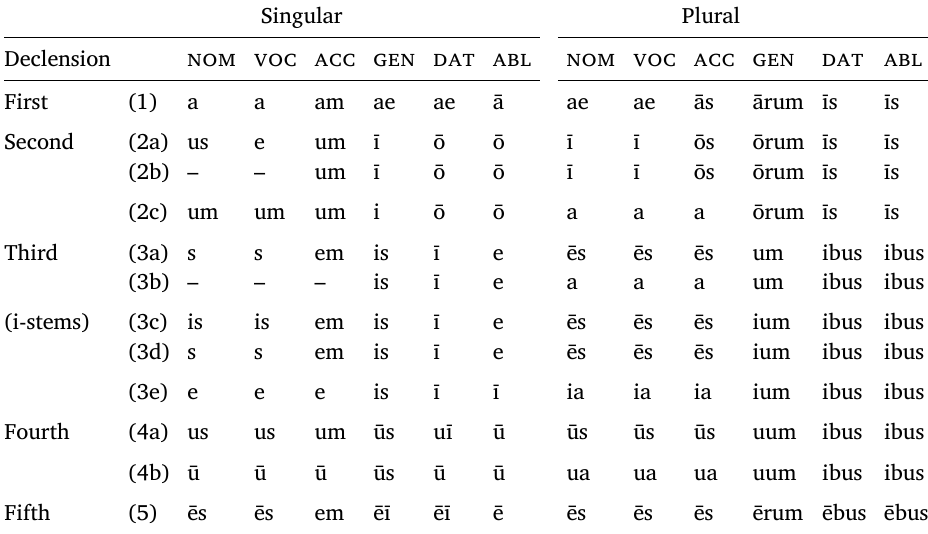
Table 1: Latin noun endings organized by declensions Singular Plural